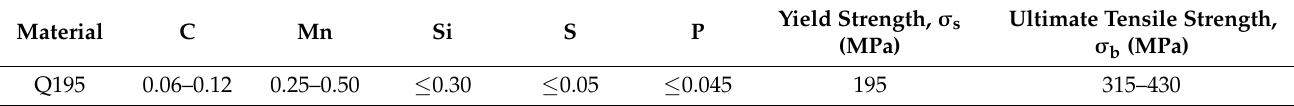
Table 1. Chemical composition (wt.%) and mechanical properties of Q195 steel.